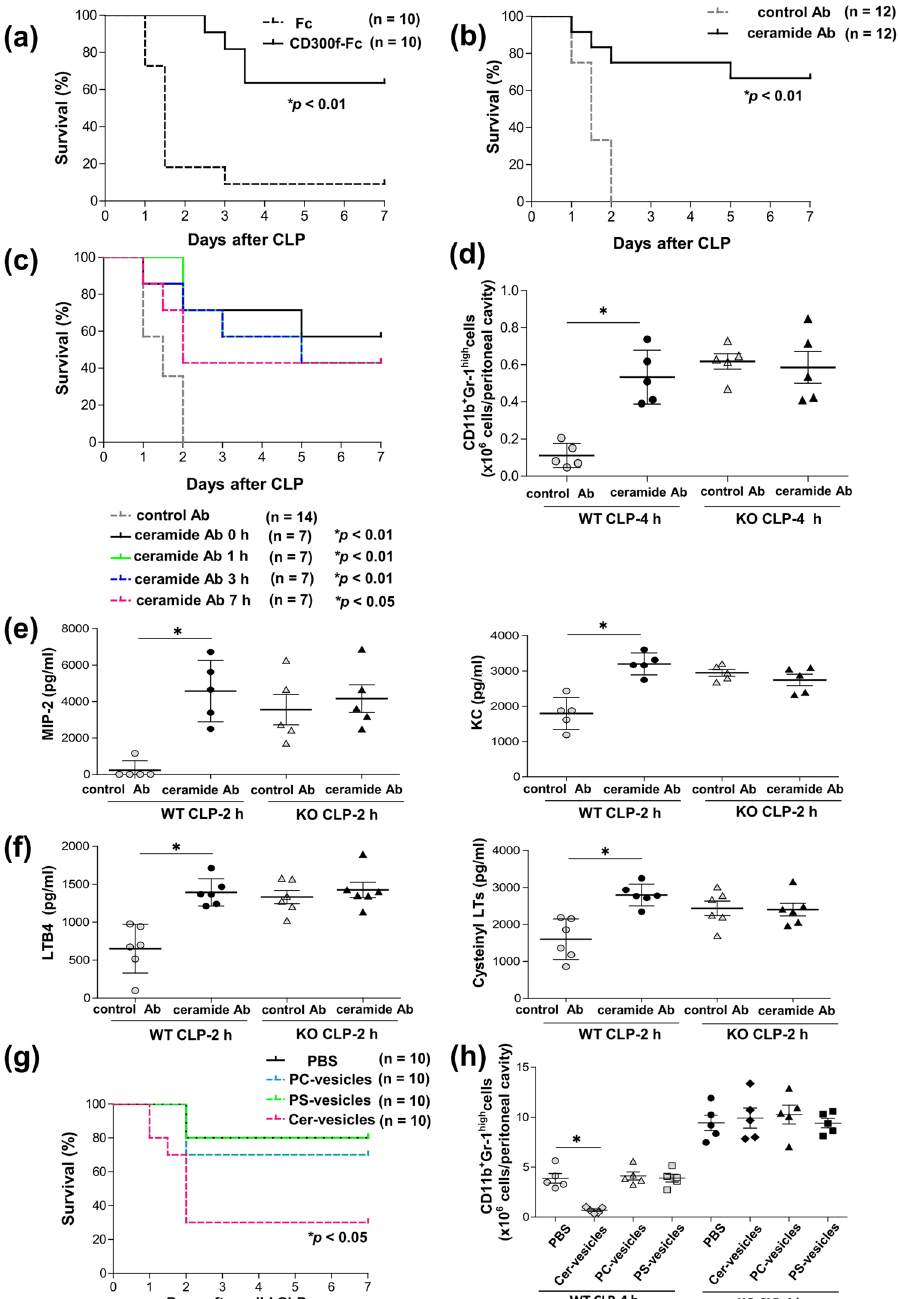
Figure 6. Treatment with an anti-ceramide Ab or CD300f-Fc ameliorated septic mortality after CLP. ( a , b ) Ab- or Fc protein-treated WT mice were subjected to CLP and monitored regarding survival. ( a ) The mice were intraperitoneally injected with 300 μ g of either CD300f-Fc or control Fc immediately after CLP (n = 10); * p < 0.01 (log-rank test). ( b ) The mice were intraperitoneally injected with 4 μ g of either the anti-ceramide Ab or isotype control Ab immediately after CLP (n = 12); * p < 0.01 (log-rank test). ( c ) Mice were intraperitoneally injected with 4 μ g of either anti-ceramide Ab at 0, 1, 3, or 7 h after CLP (n = 7) or isotype control Ab at 0 h after CLP (n = 14); * p < 0.01 or ** p < 0.05 compared to control mice (log-rank test). ( d–f ) WT or CD300f − / − mice were intraperitoneally injected with 4 μ g of either the anti-ceramide Ab or isotype control Ab immediately after CLP. ( d ) Numbers of neutrophils recruited into the peritoneal cavity 4 h after CLP (n = 5). ( e , f ) Concentrations of ( e ) MIP-2, KC, or LTB4 or ( f ) cysteinyl LTs in PLF from mice 4 h after CLP (n = 5 to 6). ( g , h ) WT or CD300f − / − mice were intraperitoneally injected with 100 μ g of vesicle containing ceramide, PC, PS, or PBS as a control immediately after CLP. ( g ) Mice (total n = 10 per group) were monitored regarding survival; * p < 0.05 compared to control mice (log-rank test). Data were pooled from two independent experiments. ( h ) Numbers of neutrophils recruited into the peritoneal cavity 4 h after CLP (n = 5). ( d,e,f,h ) The data are representative of two independent experiments. The data are expressed as mean ± SD; * p < 0.01 (Student’s t